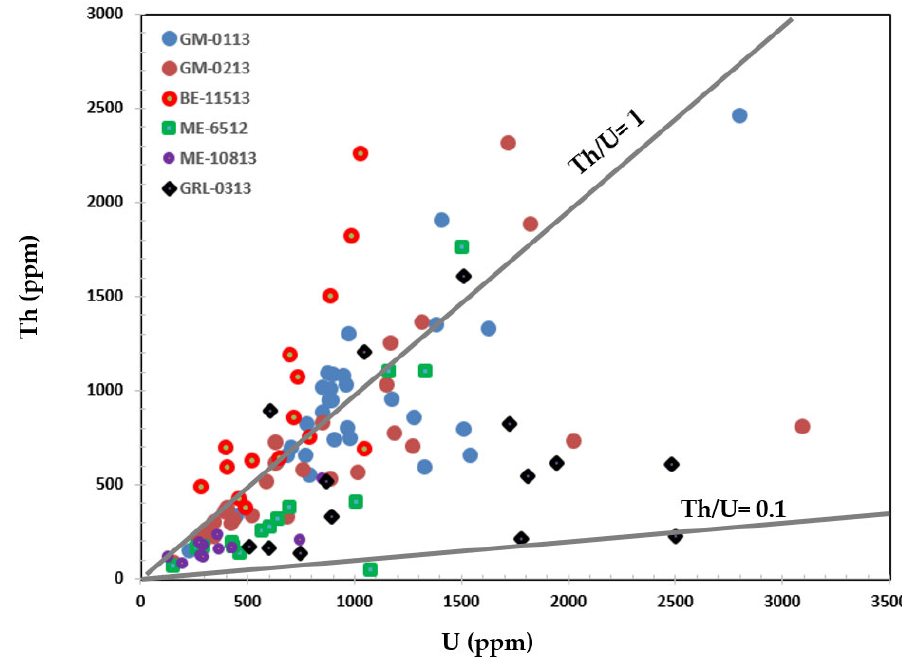
Figure 18. Binary plot of Th versus U for the zircon samples. As shown in the legend, samples GM ‐ 0113 and GM ‐ 0213 came from the Gua Musang area. Sample BE ‐ 11513 was collected from the Bentong area along the suture. Sample ME ‐ 6512 and ME ‐ 10813 were collected from the Semantan Formation. Sample GRL ‐ 0313 was collected from Langkawi Islands, far from the Bentong ‐ Raub Suture Zone.